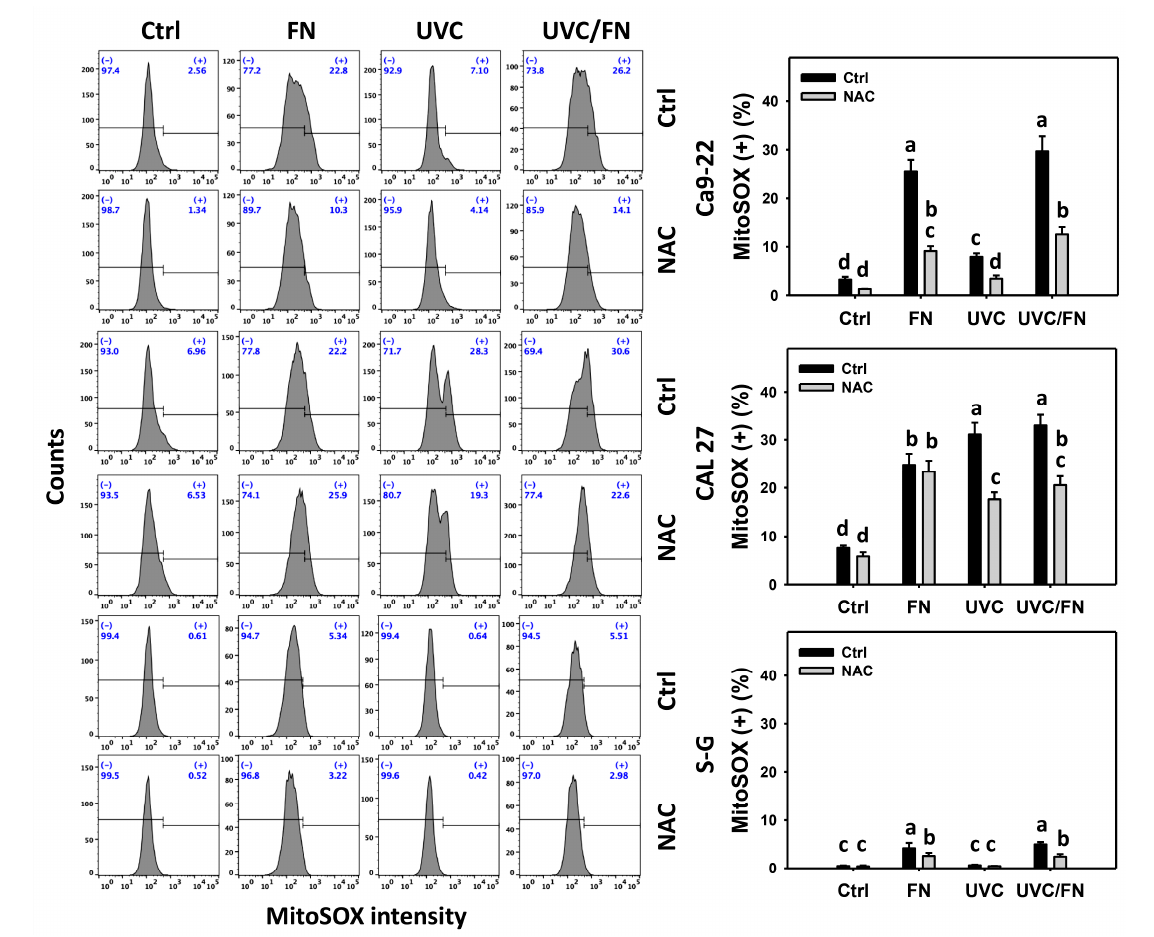
Figure 7. MitoSOX determination. There are four kinds of treatments for oral cancer and non-malignant oral (S–G) cells: control, FN (300 μ g/mL), UVC (10 J/m 2 for Ca9-22; 15 J/m 2 for CAL 27 and S–G), and UVC/FN (10 J/m 2 /300 µ g/mL for Ca9-22; 15 J/m 2 /300 µ g/mL for CAL 27 and S–G). NAC indicates that cells were pretreated with 10 mM NAC. Their intensity changes were evaluated by flow cytometry after a 24 h treatment. MitoSOX (+) populations are indicated with (+). Data are given as means ± SD ( n = 3). They significantly differ when the lower-case letters are not overlapping ( p < 0.05).